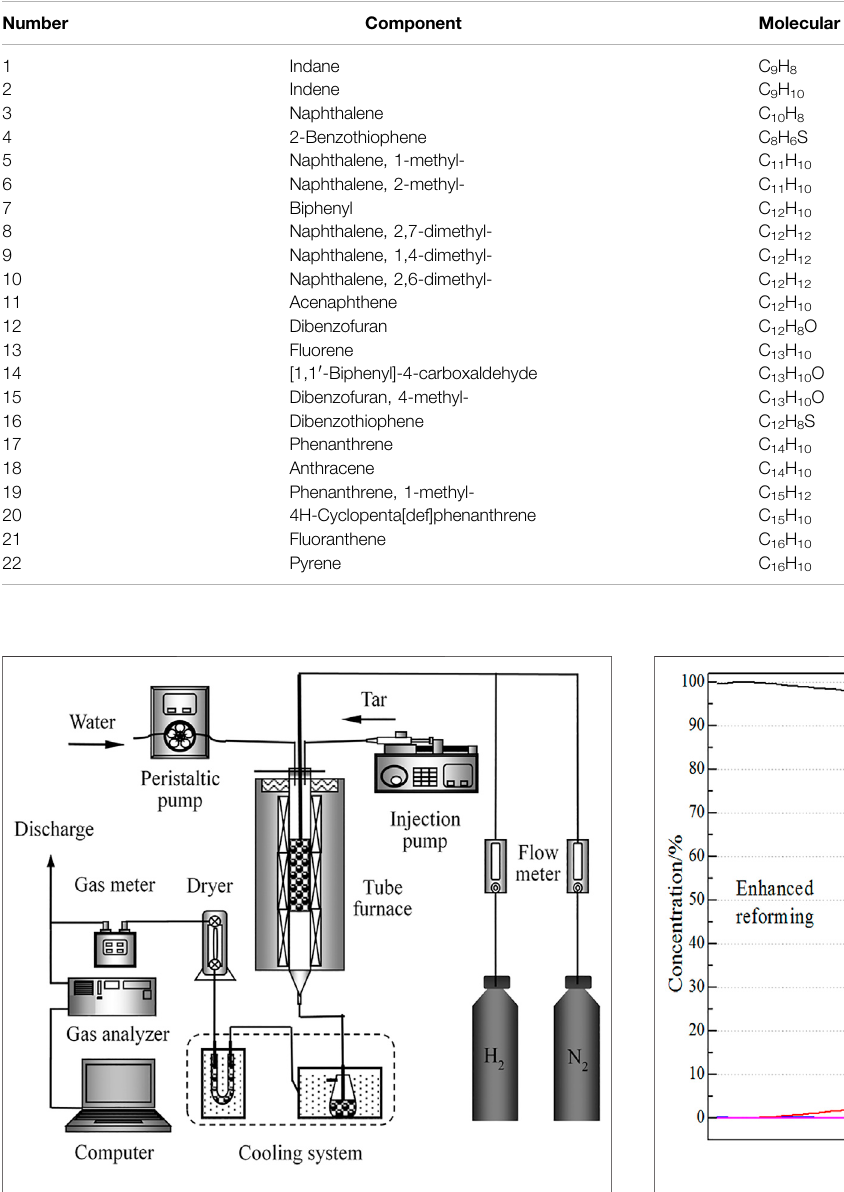
FIGURE 1 | The reforming experimental apparatus. FIGURE2| Diagramofthereformed gasconcentrationsasafunctionof